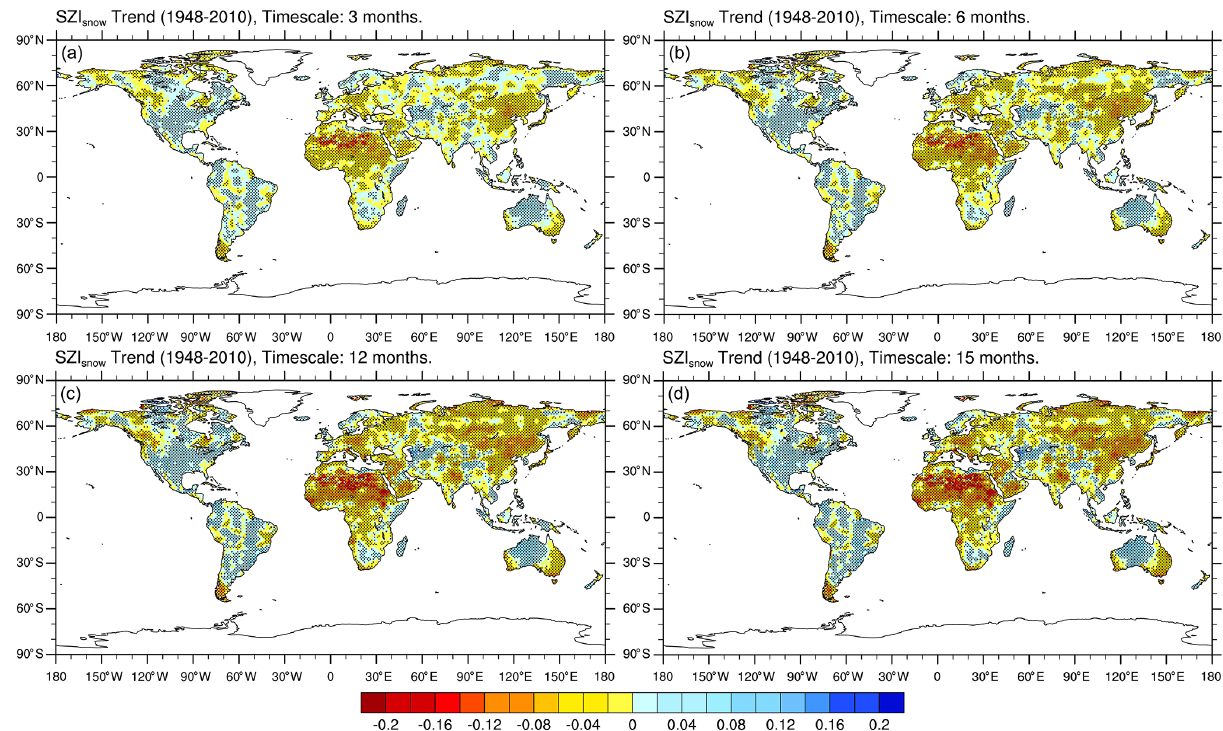
Figure 7. Spatial distribution of the linear annual trend (changes per 50 years) in the SZI snow during the period 1948–2010, at various timescales. The stippling denotes the trend being statistically significant at the 95% confidence level. Table 3. Summary of large-scale drought occurrence for each continent. In the fourth column, the duration of the drought is shown in months, and the period is listed in parentheses. In the final column, the spatial extent is given as a percentage of the total continental area, and the date at which the maximum spatial extent occurred is listed in